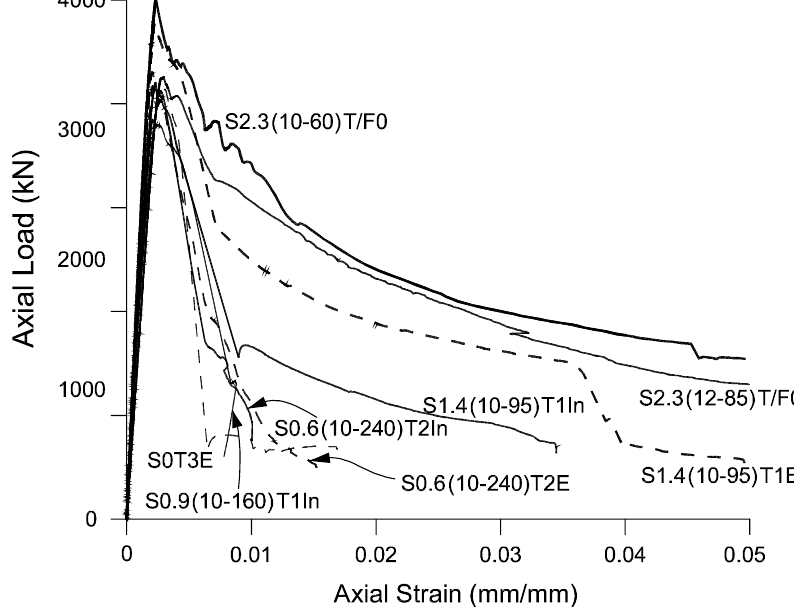
Figure 4. Axial load versus axial strain of TRC-TSR confined